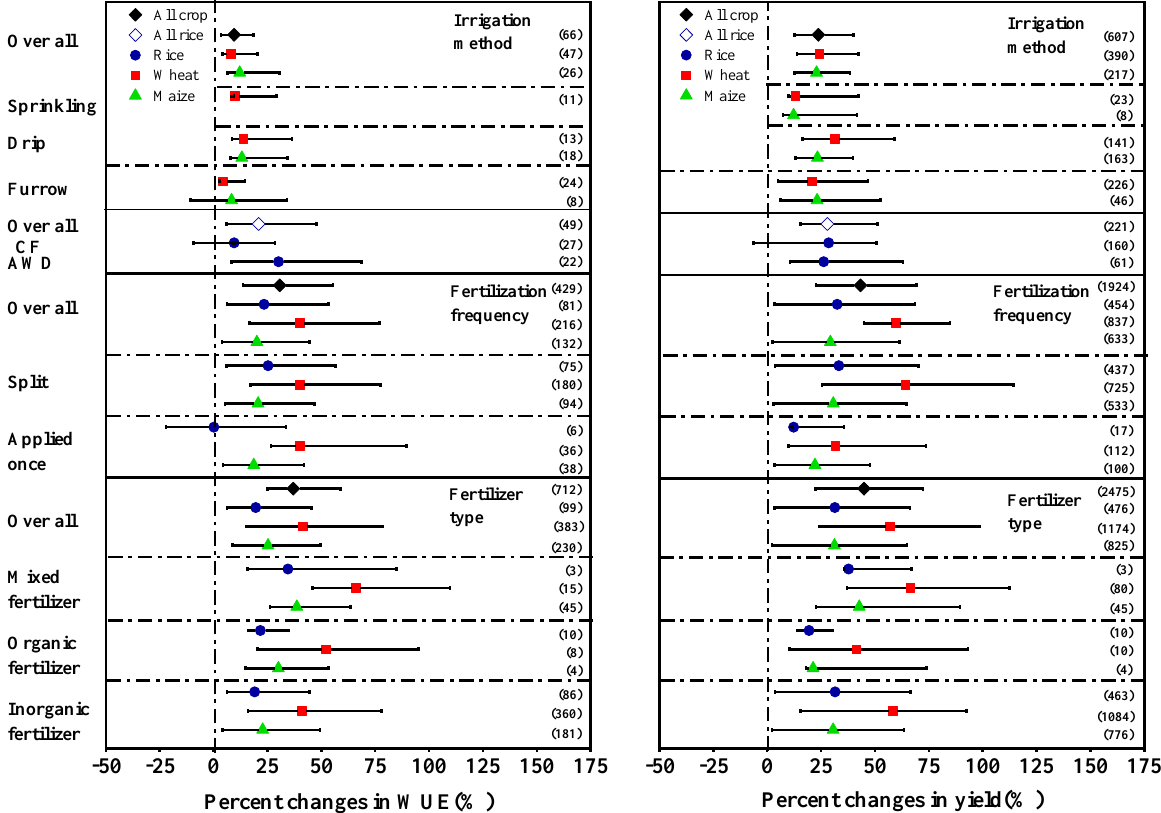
Figure 7. Percent changes in crop yield and WUE according to agronomy practices (fertilizer type, fertilization frequency, and irrigation methods) of maize, wheat, and rice, expressed as the mean value with bias-corrected 95% confidence intervals. Observation numbers for each group are given in parentheses. Triangles represent field experiment of maize, squares represent field experiment of wheat, circles represent field experiment of rice, hollow diamonds represent average of rice field experiment, and black diamonds represent average of three crop field experiment of maize, wheat, and rice.